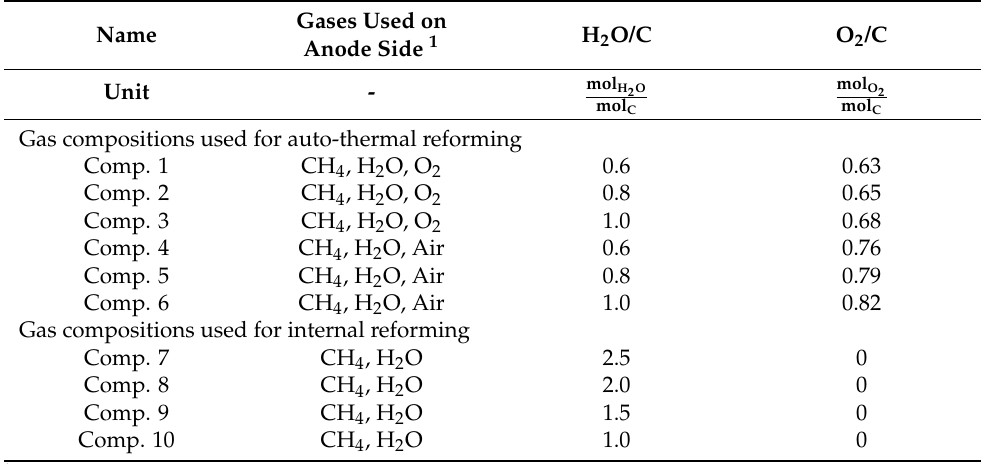
Table 2. Initial gas compositions for auto-thermal reforming and internal reforming of methane.